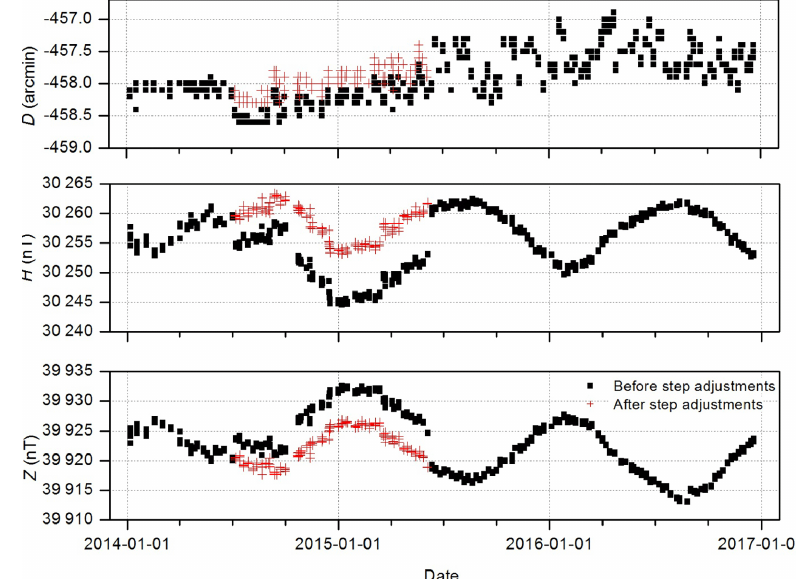
Figure 5. D , H and Z baselines before adjustment (solid rectangular) and after adjustment (cross) of